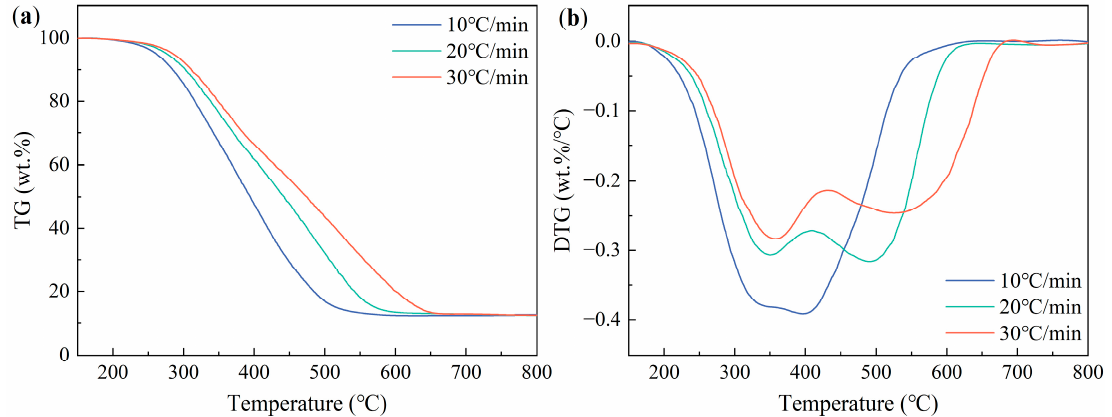
Figure 3. TG ( a ) and DTG ( b ) curves of ternary blends at heating rates of 10, 20, and 30 °C/min. Figure 3. ( a ) TG and ( b ) DTG curves of ternary blends at heating rates of 10, 20, and 30 ◦